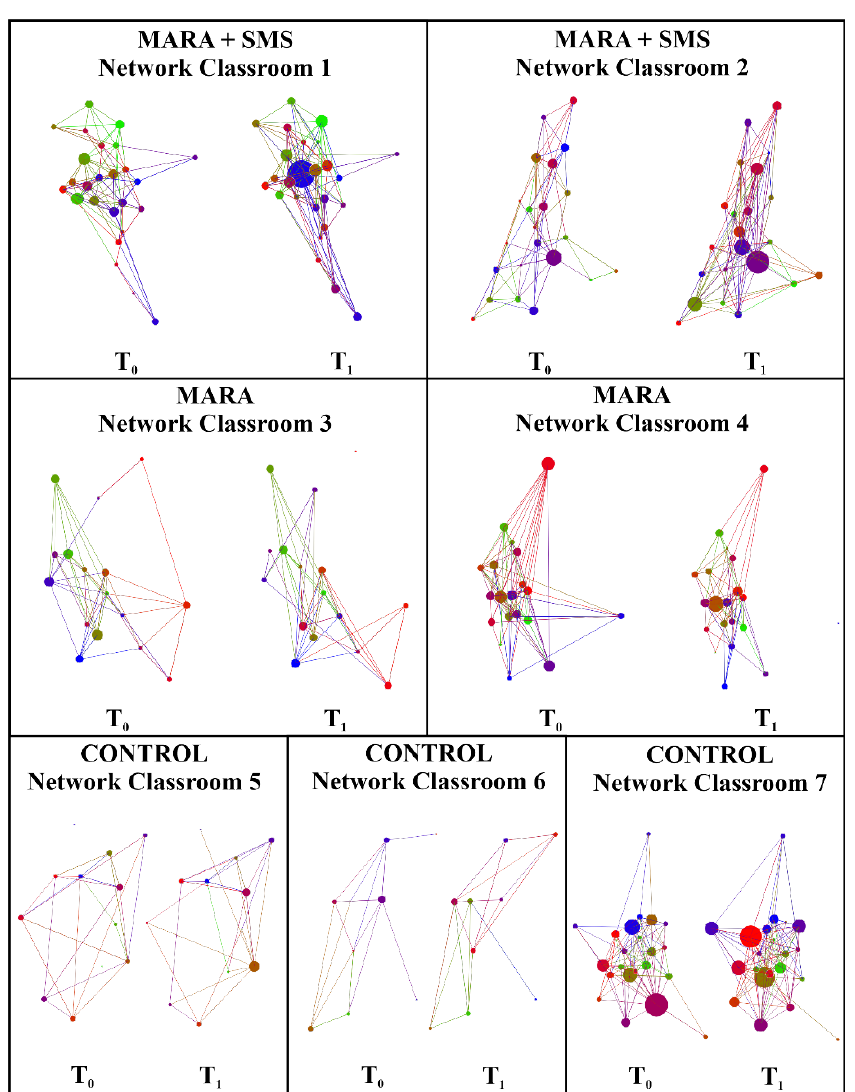
Figure 2. Friendship networks before ( T 0 ) and after ( T 1 ) the intervention of the MARA + SMS, MARA, and control schools. For nodes: color is the child, and size is the in-degree of the child. For edges: color is the color of the targeted child.